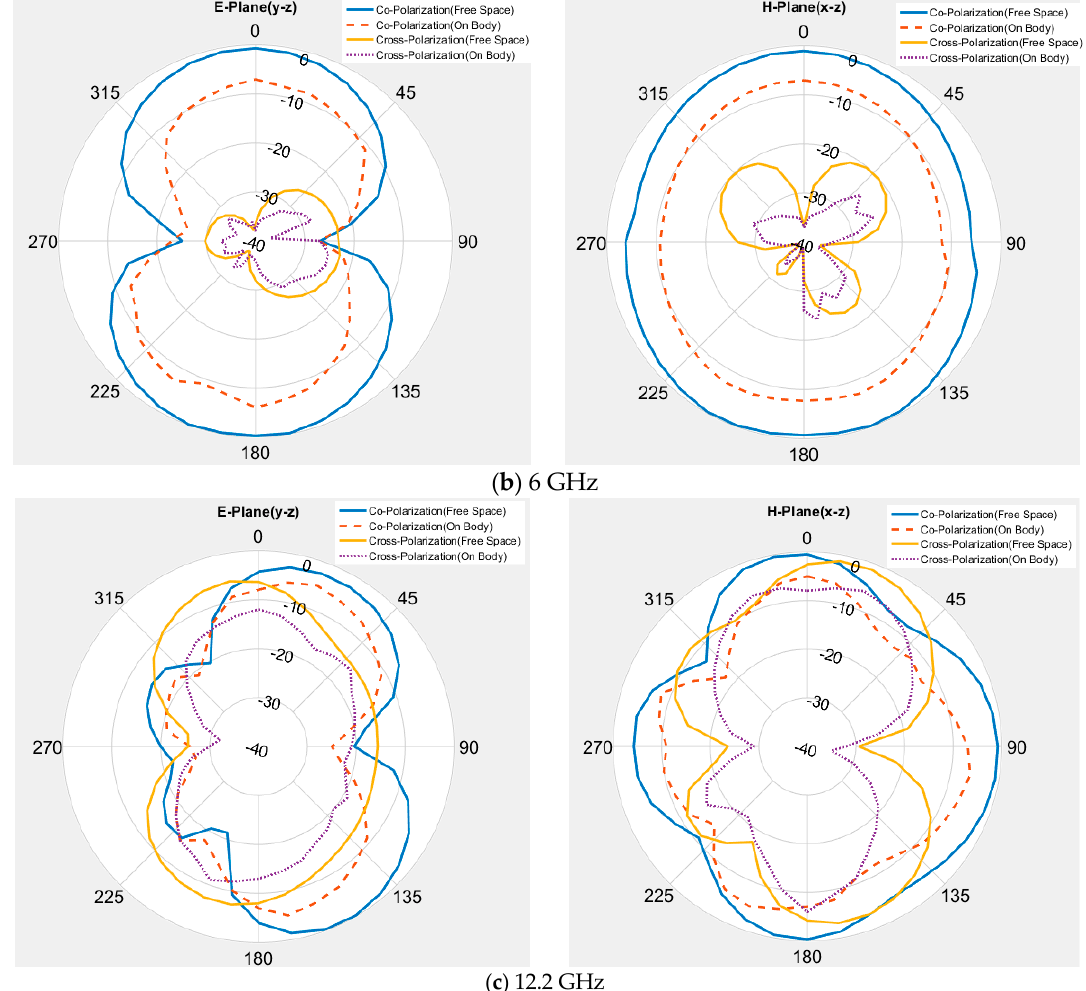
Figure 12. Experimental radiation pattern at ( a ) 5.2 GHz, ( b ) 6 GHz, and ( c ) 12.2 GHz